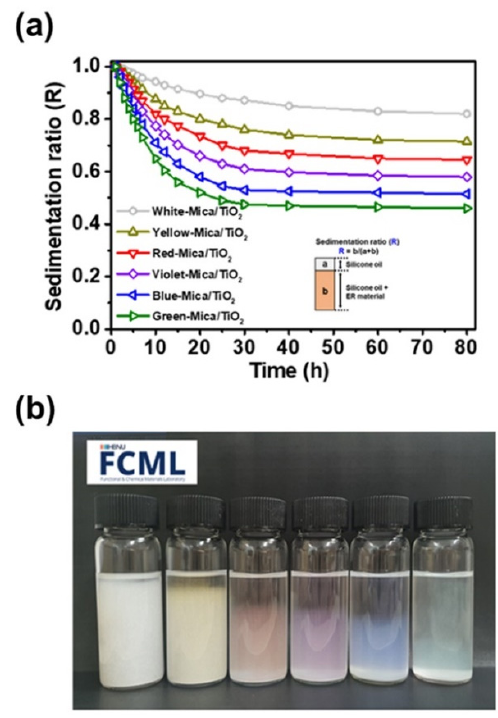
Figure 6. ( a ) Dispersion stabilities of color mica/TiO 2 -based ER fluids dispersed in silicone oil (3.0 wt%) and ( b ) digital images of color mica/TiO 2 -based ER fluids after 20 h.